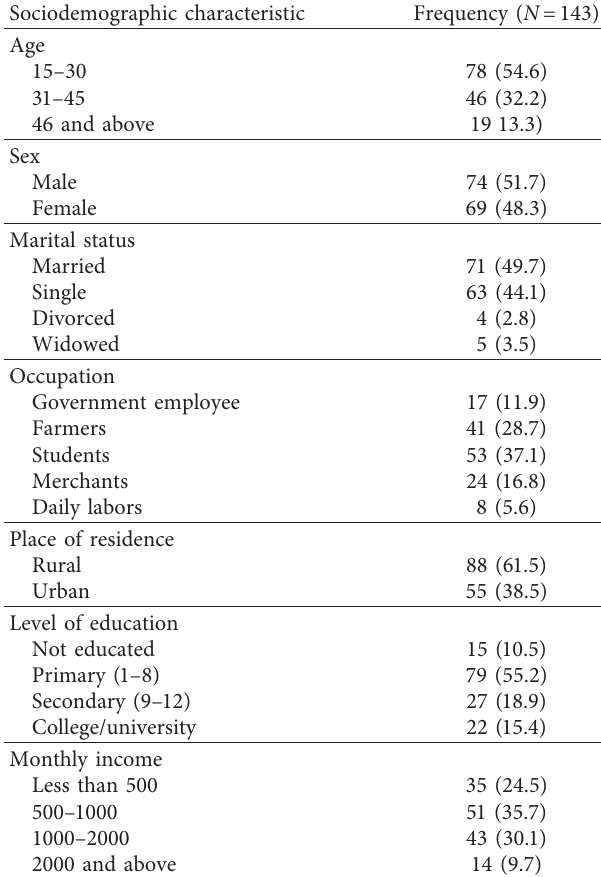
Table 1: Sociodemographic characteristics of epileptic patients on AEDs at MTUTH from March 10 to April 10,